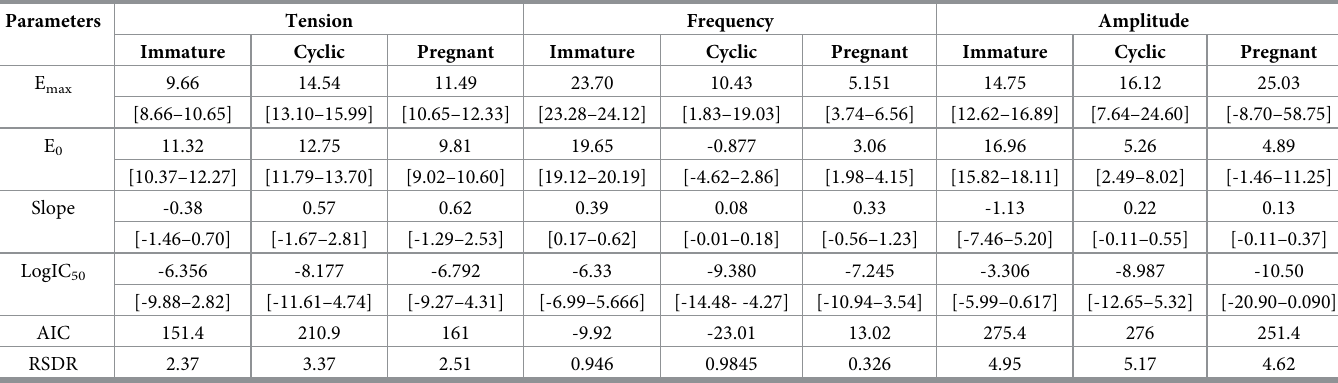
Dose-response value (shown as mean with 90% confidence interval) of calculated parameters based on changes in tension and amplitude and frequency of contractions of the uterine myometrial strips collected from gilts immature (n = 6), on days 12–14 of the oestrous cycle (cyclic; n = 6) and 12–16 of pregnancy (pregnant; n = 6) and treated with increasing (10 − 13 –10 − 1 M) concentrations of quercetin